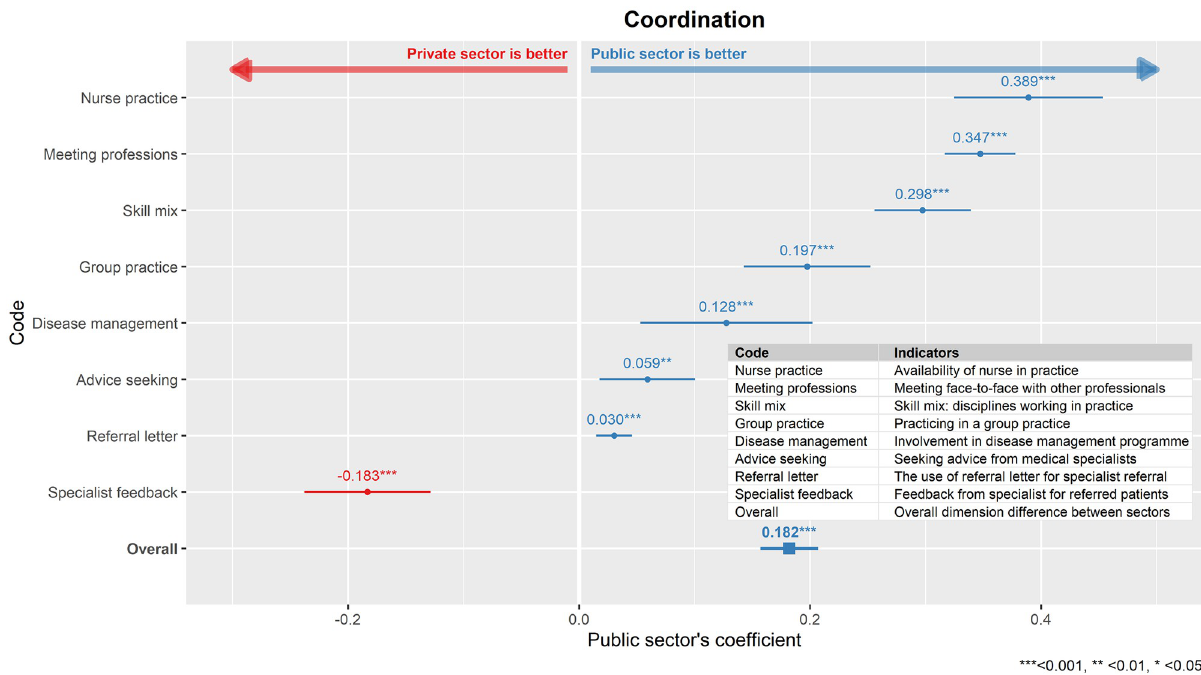
Fig 4. Comparison between public and private primary care clinics in the dimension of coordination. The public sector’s regression coefficient ( β public ) for each indicator model as well as overall dimension model was shown here together, with its 95% confidence